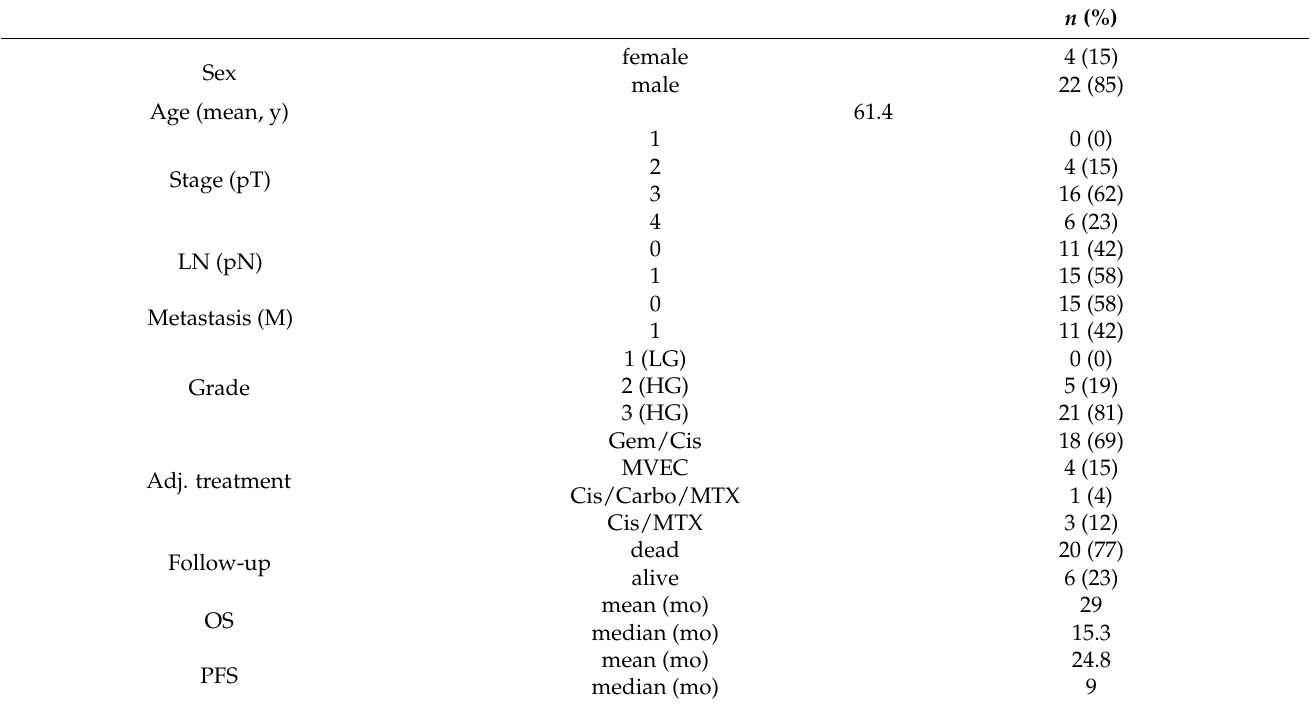
Table 1. Clinico-pathological data of the